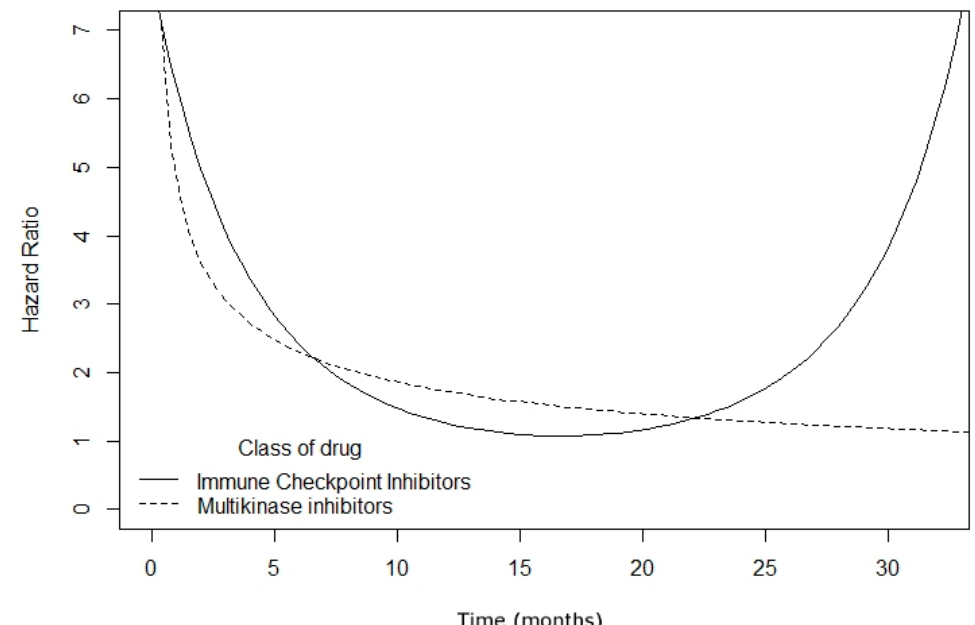
Figure 2. Estimated hazard ratios (HRs) over time between PFS and OS in clinical trials of ICIs and multikinase inhibitors (MKIs) for advanced HCC.